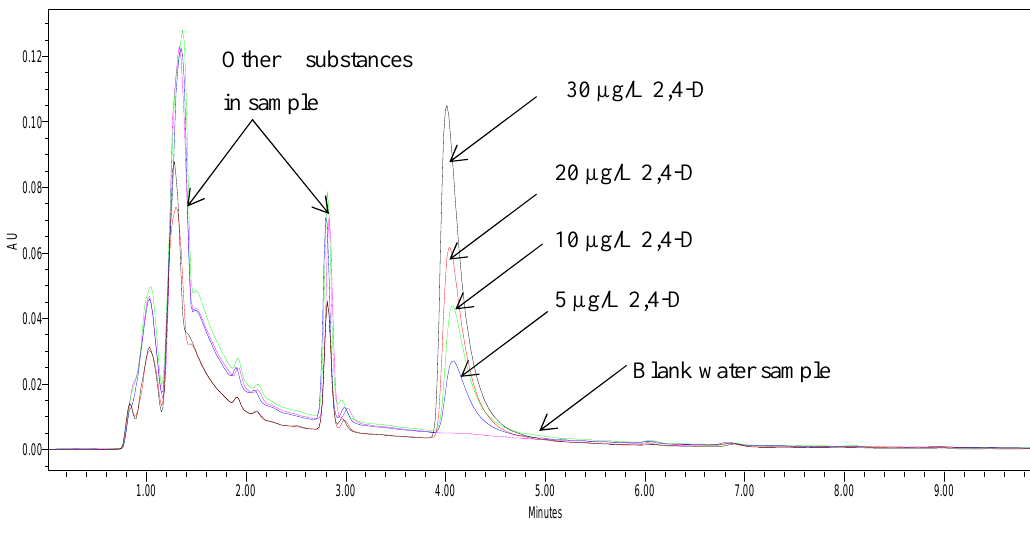
Figure 8. A HPLC chromatogram of water samples from rice fields spiked with 2,4-D standards (5-30 µ gL -1 ). The appearance of many other chromatographic peaks indicated that the water sample had a complex matrix.